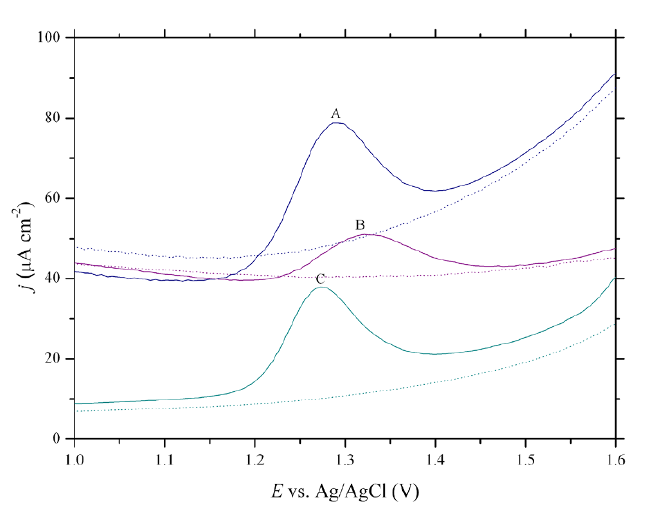
Figure 2. DP voltammograms of linuron (0.036 μmol cm -3 ) in 0.1 mol dm -3 sulphuric acid applying studied electrodes (A) GCB, (B) GC and (C) GC-Metrohm, and corresponding baselines signed as dot lines. Experimental conditions: voltage step 0.006 V; sweep rate 0.05 V s -1 . The electrodes were electrochemically activated before measurement.